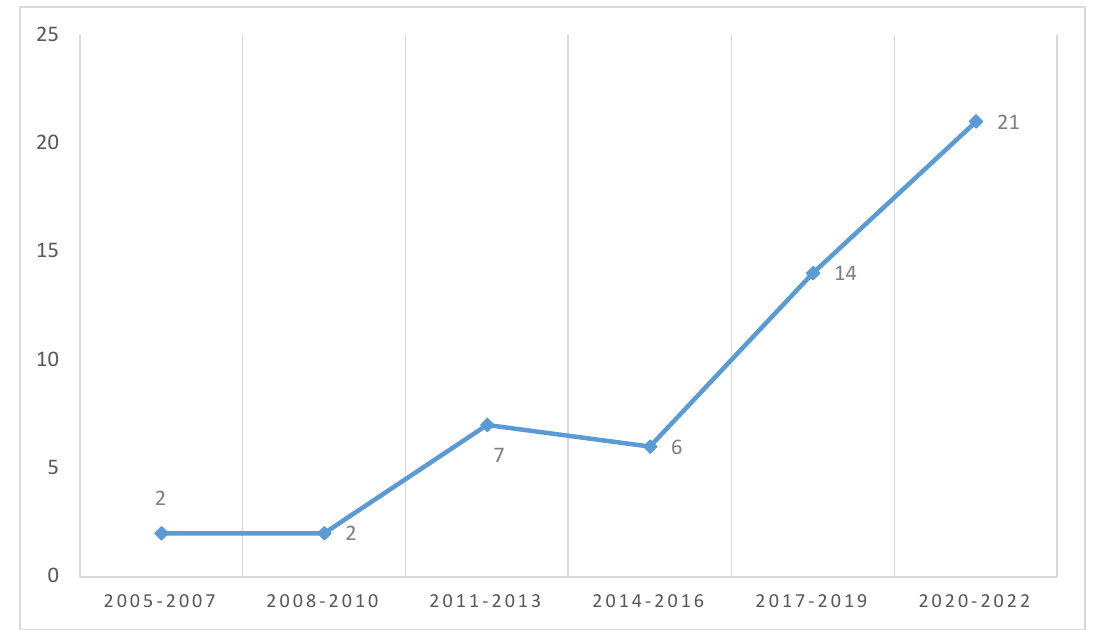
Figure 2. Diachronic productivity.